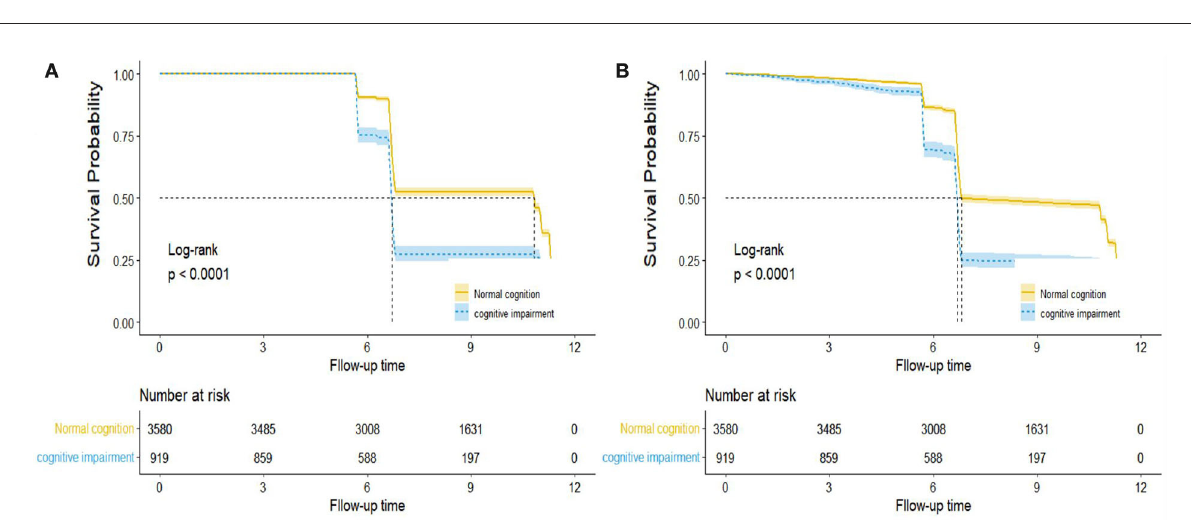
FIGURE3 Reverse Kaplan–Meier survival curve for the median follow-up time by cognition function in all-cause (A) and CVD (B) mortality. Note: This is not the KM curve for the outcome events. In this plot, losses to follow-up were treated as “events” while the development of outcome events was treated as “censored.” The dashed line describes the median follow-up time, and the areas of shadow represent 95% CIs.